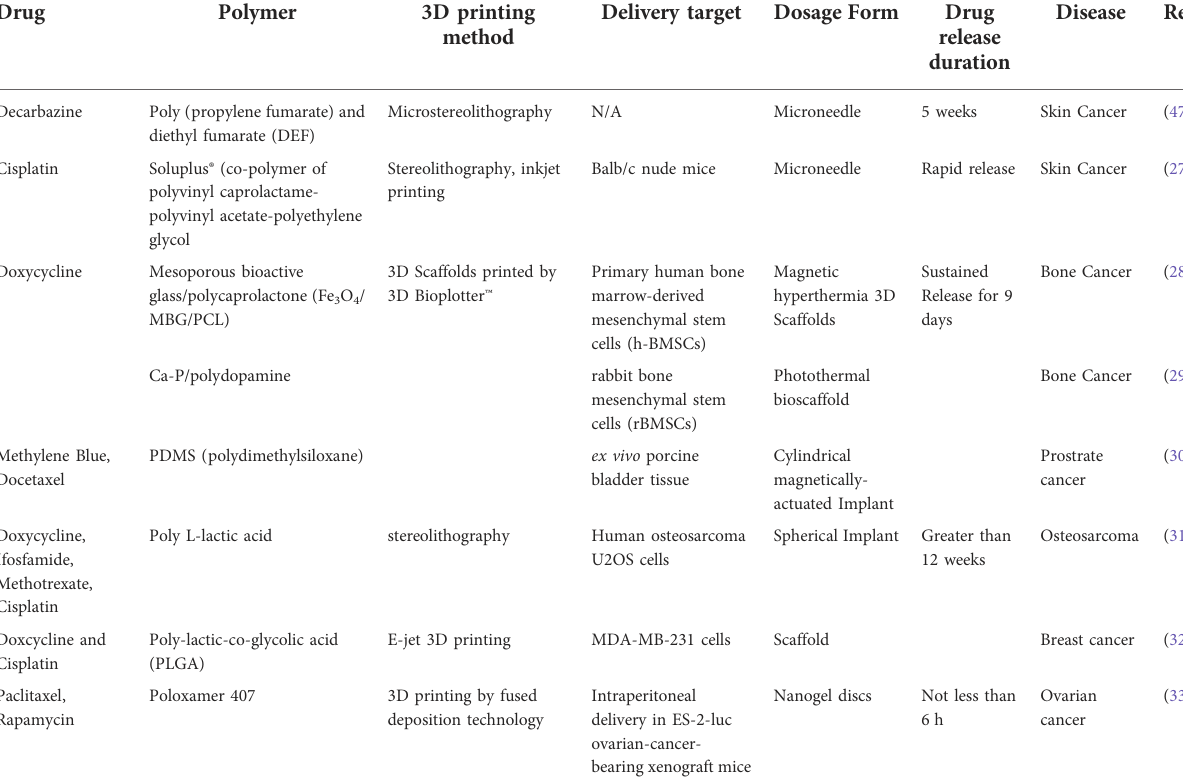
TABLE 1 Delivery systems